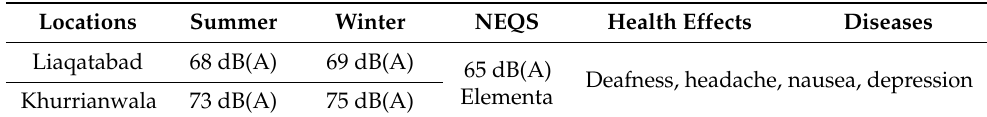
Table 6. Seasonal variation of noise levels at selected sites in comparison to NEQS and corresponding health